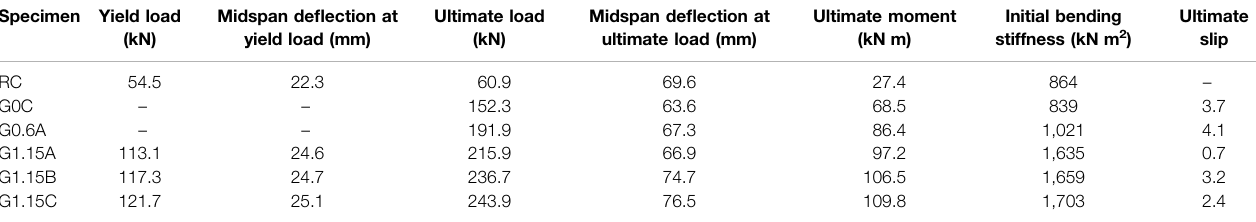
TABLE 3 | Experimental